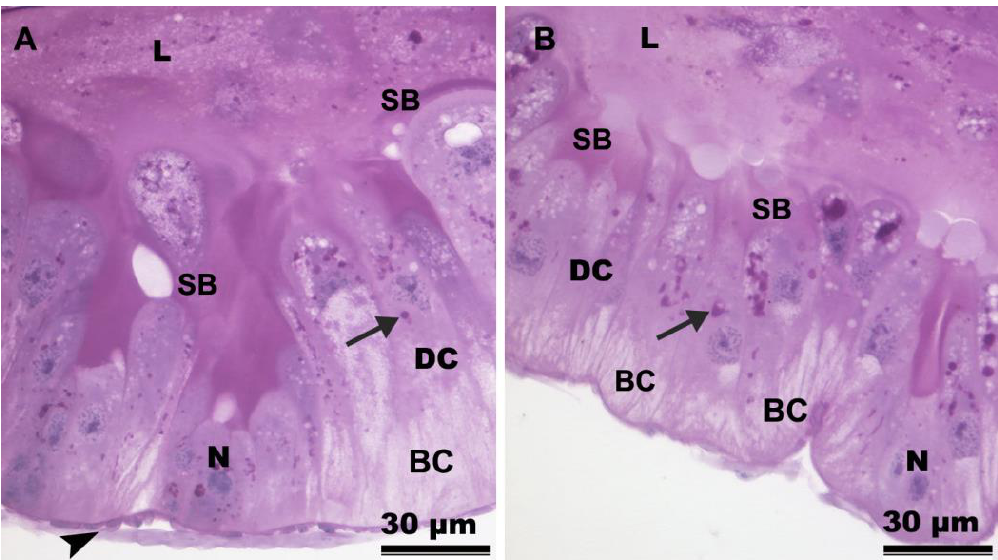
Figure 2. Light micrographs of the midgut of Friesella schrottkyi worker submitted to P.A.S histochemical test. ( A ) Anterior midgut region showing digestive cells (DC) with positive granules (arrow) in the median-apical cytoplasm and weak reaction in the basal cytoplasm (BC). Note that striated border (SB) has positive reaction. ( B ) Posterior midgut region showing digestive cells (DC) with positive granules (arrow) in the median-apical cytoplasm and weak reaction in the basal cytoplasm (BC). Arrowhead—muscle, L—midgut lumen, N—nucleus of the digestive cell.